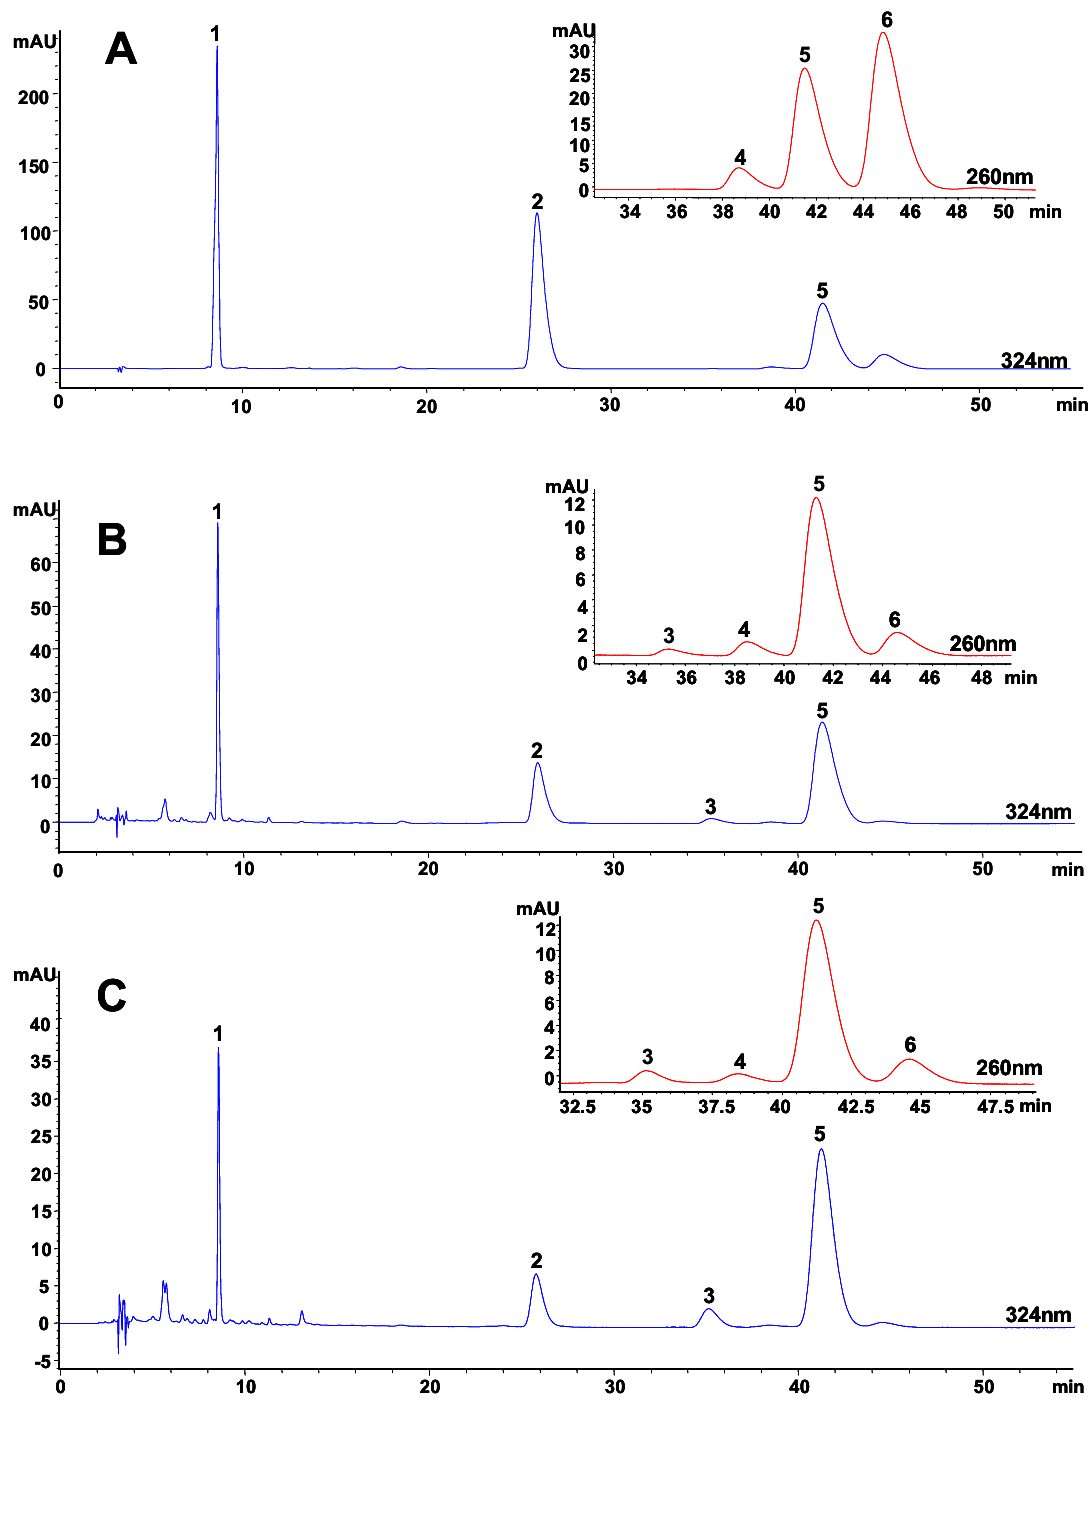
Figure 3. HPLC chromatograms of (A) mixed standards and typical extracts of Angelica sinensis extracted by (B) sonication extraction, (C) pressurized liquid extraction, (D) supercritical fluid extraction, (E) hydrodistillation and (F)